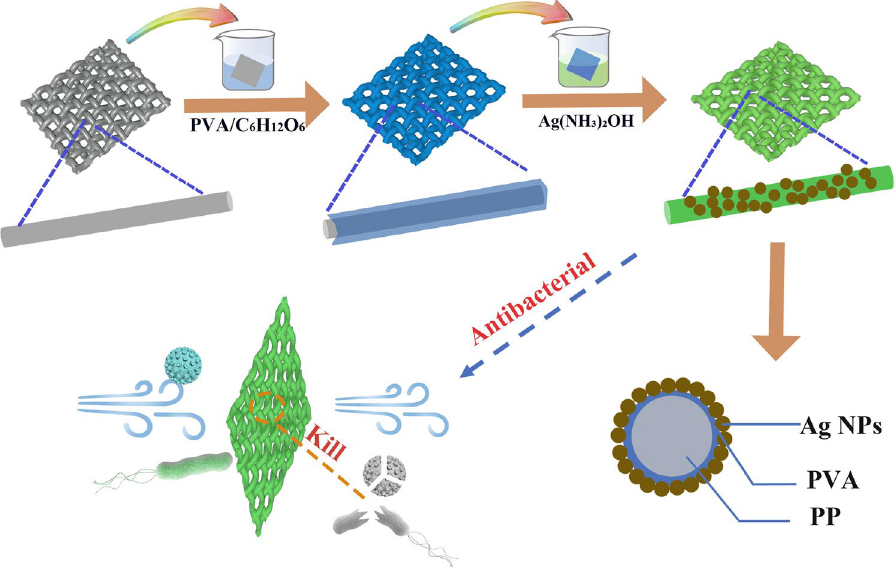
Figure 1. Schematic diagram showing the preparation of Ag/PVA/PP fabrics and their antibacterial